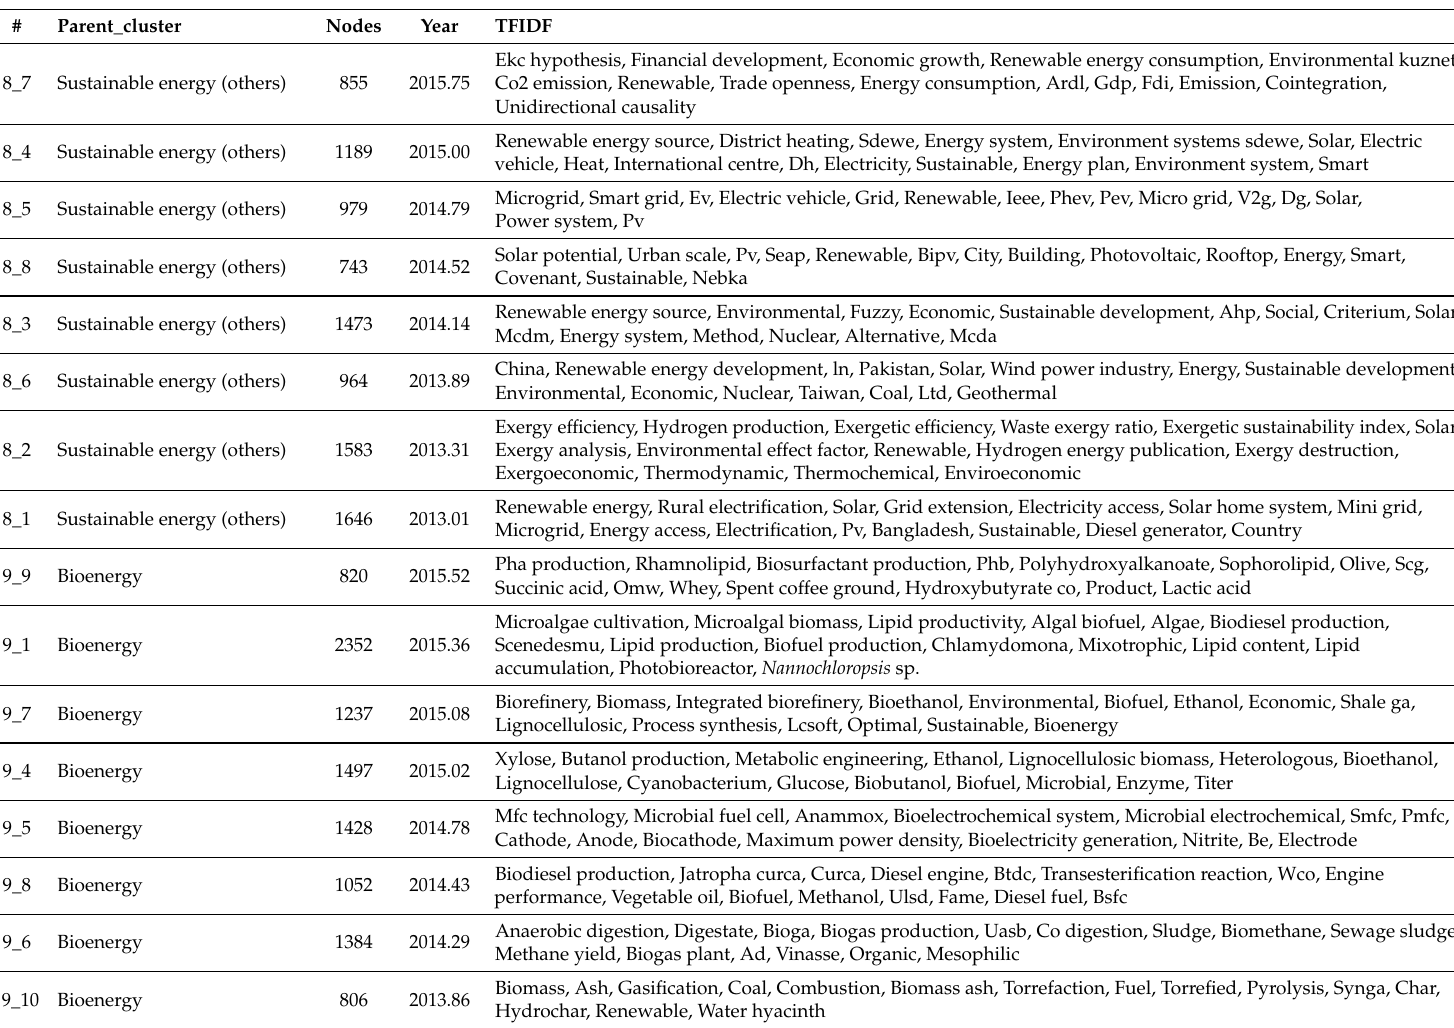
Table 2. List of energy-related subclusters: subclusters of energy-related clusters (8 and 9) and subclusters that are related to energy of other